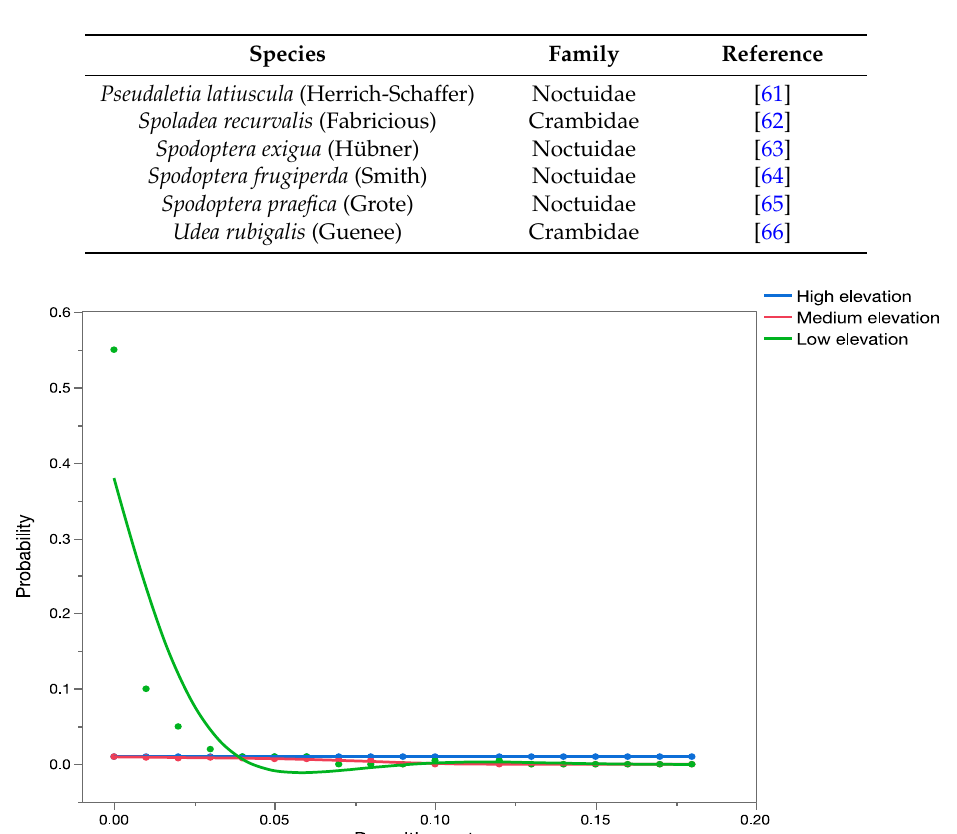
Figure 3. Overlay chart showing forecast of expected parasitism rates (proportion on x -axis) for C. marginiventris at low-, medium-, and high-elevation sites using early published data (Table 6). Table 6. List of hosts of C. marginiventris in its native range known prior to its introduction to Hawaii in 1942.